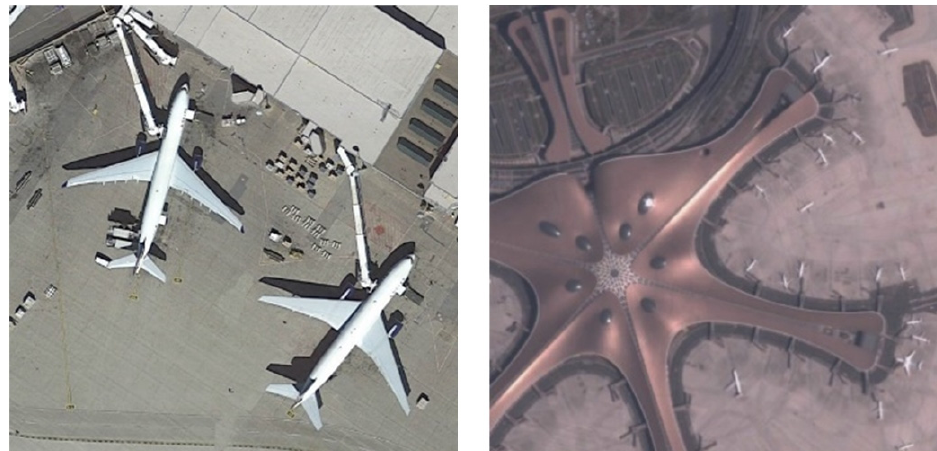
Figure 1. Comparison of samples in the DIOR dataset ( left ) and satellite video ( right ). According to the COCO dataset [54] and Chen et al. [55], a small object can be defined by its absolute size (less than 32 × 32 pixels) and relative size (i.e., the proportion of the object area < 0.12%). We statistically compared the size information of aircraft in the DIOR dataset and the satellite video used in this paper. In terms of absolute and relative sizes, the small aircraft in the DIOR dataset accounted for 23.03% and 17.07% of the total number of aircraft, respectively, while the corresponding values for the satellite video were 89.44% and 92.46%, respectively. Therefore, for aircraft detection in satellite video, size is a sig- nificant problem. Detecting small objects which lack visual features and texture infor-